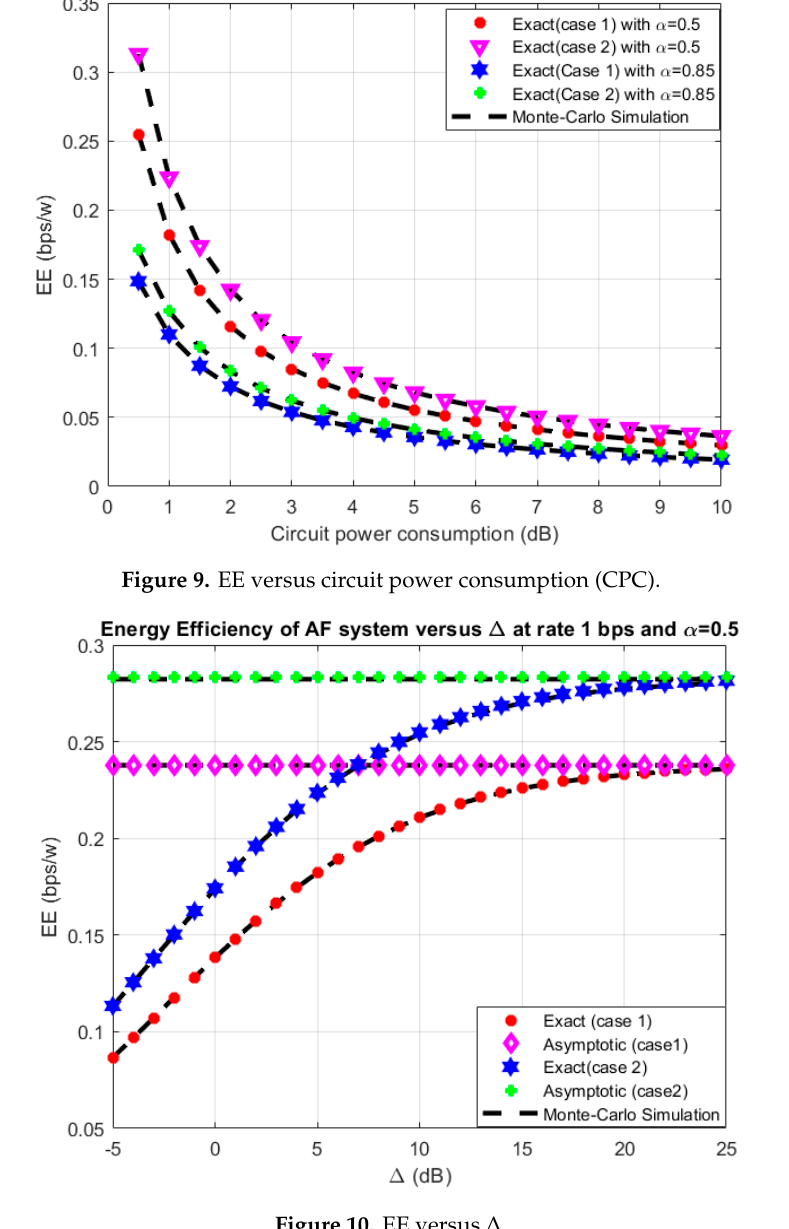
Figure 10. EE versus Δ .